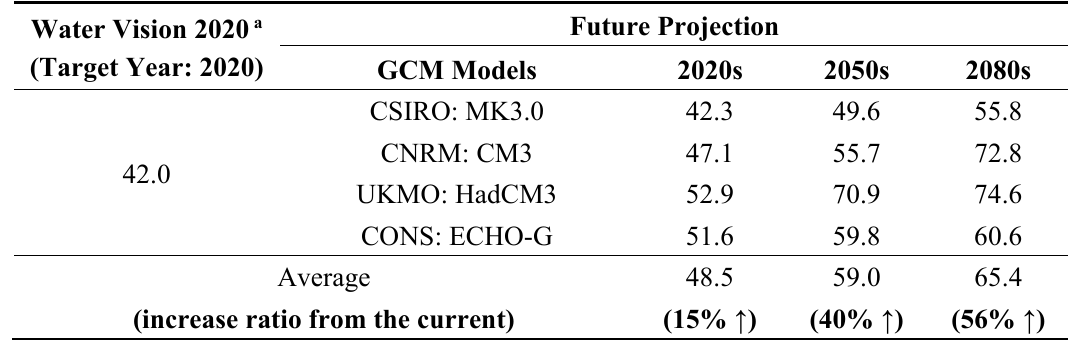
Figure 6. Monthly flow variations in the projections for the Han River basin, Korea. Table 3. The average water shortage projections in the Han River basin (unit: 10 6 m 3 ).